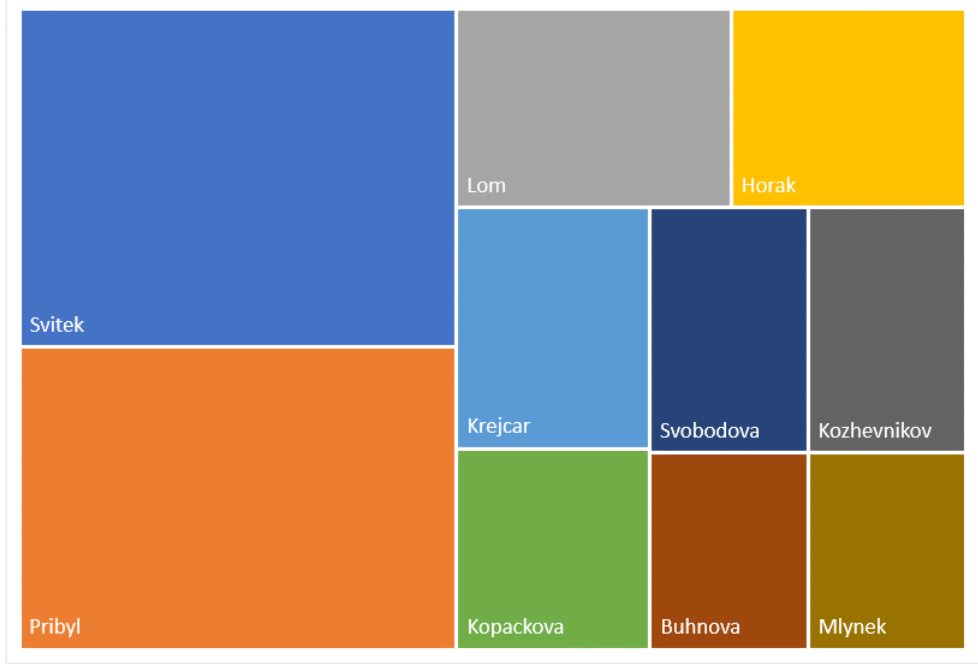
Figure 11. An overview of Czech authors publishing on the topic of Smart cities. Source: own analysis as per Web of Science (2022).